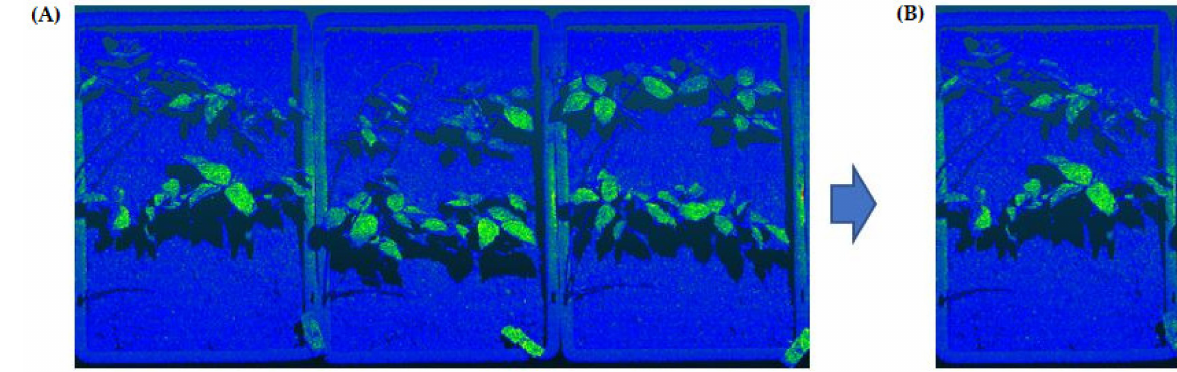
Figure 2. A partial view of a mung bean point cloud data ( A ) and a view of a separated tray sample ( B ). Each data file was divided into 12 (number of trays) equal parts along the y -axis to separate the trays from each